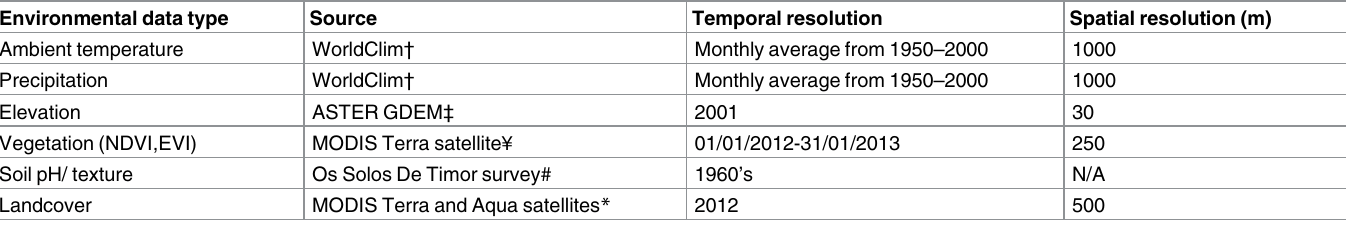
Table 1. Summaryof environmental data sources considered in this